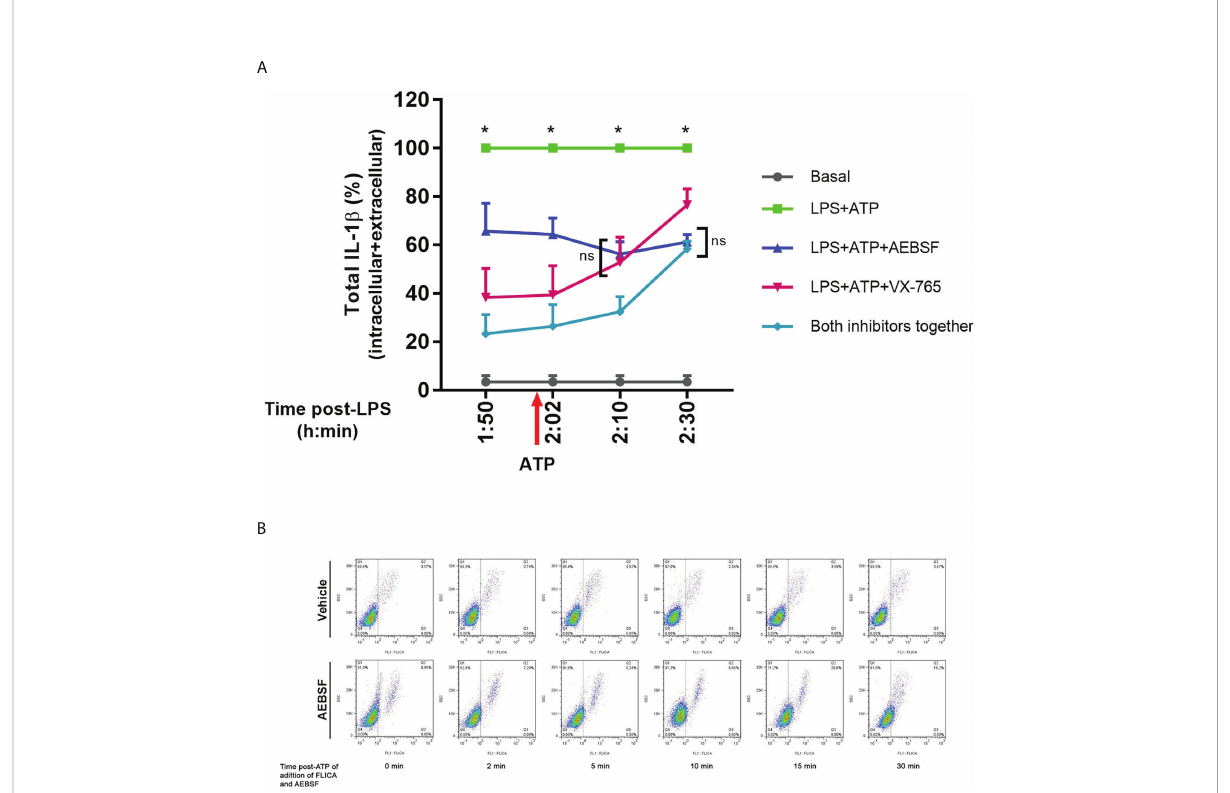
FIGURE 7 Dynamic of pro-IL-1 b processing by caspase-1 and NSPs. (A) Total (intracellular+extracellular) mature IL-1 b levels determined by ELISA in neutrophils stimulated with LPS+ATP either in the presence of AEBSF, VX-765 (caspase-1/4 inhibitor) and both inhibitors together, added at different time points before and after in fl ammasome activation with ATP. Neutrophils were stimulated or not with LPS and 2 h later with ATP. Ten min before ATP treatment or 2, 10 or 30 min after, cells were treated with AEBSF (0.35 mM), VX-765 (50 µM) or both inhibitors together. At 5 h post-LPS stimulation, total (intracellular+extracellular) concentrations of mature IL-1 b were determined by ELISA. Data are depicted as % of the levels of mature IL-1 b produced upon LPS+ATP stimulation alone and represent the mean ± SEM of experiments performed in duplicate with 4 donors. *p<0.05 LPS+ATP vs each treatment at the corresponding time point; ns: non-signi fi cant; Two-way ANOVA with Tukey ’ s multiple comparisons test. (B) Effect of inhibition of NSPs at different time points after in fl ammasome activation with ATP on caspase-1 activity. Neutrophils were stimulated with LPS for 2 h, and then were treated with ATP to induce in fl ammasome activation. At the time points post ATP- addition indicated below each dot plot, FLICA was added or not simultaneously with AEBSF to trap during a 5 minutes-lapse all active caspase- 1. Images depict representative dot plots of experiments performed with 4 donors showing FLICA fl uorescence of neutrophils after having excluded the